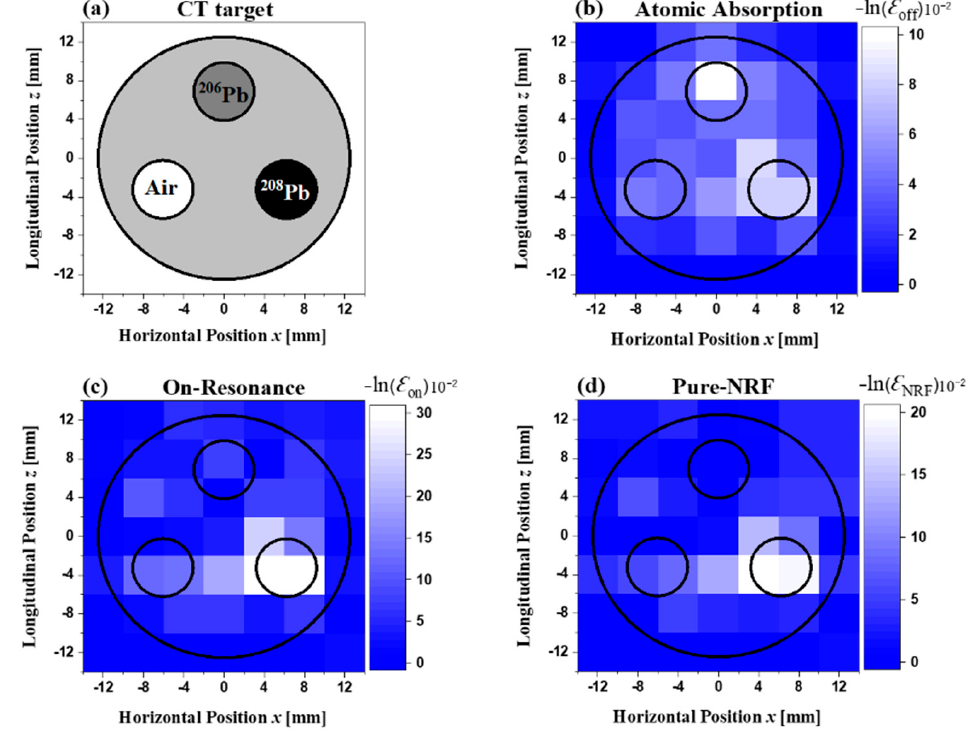
Figure 10. ( a ) CT target cross-sectional slice image at z = 17 mm, with reconstructed CT images of the ( b ) atomic attenuation, ( c ) on-resonance attenuation, and ( d ) pure NRF case.